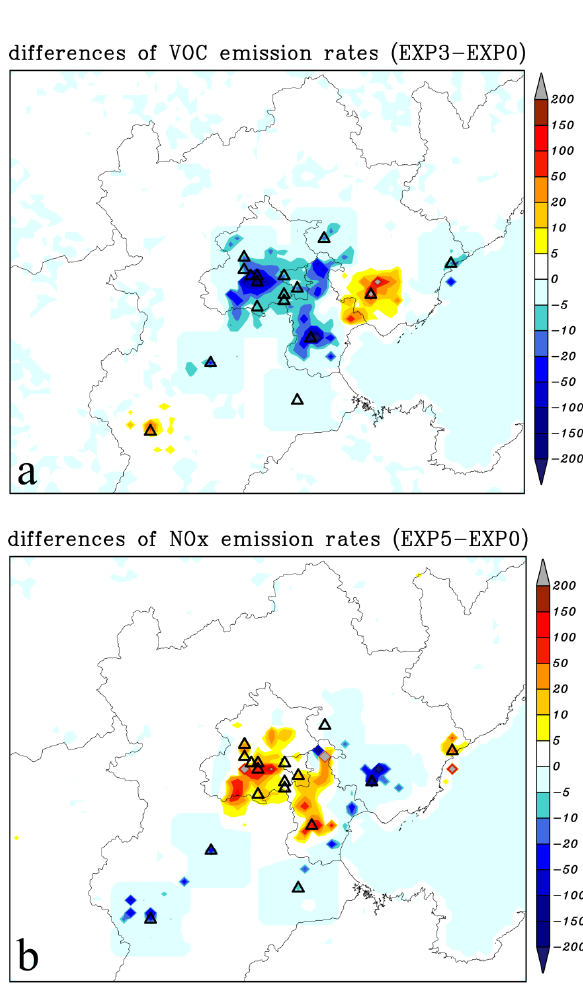
Fig. 8. (a) Departure of VOCs emission rates (ton/km 2 /year) in EXP3 from those in free run during 10am-4pm on 14 August 2008 (LT); (b) Departure of NOx emission rates (ton/km 2 /year) in EXP5 from those in free run during 10am-4pm on 14 August 2008 (LT).